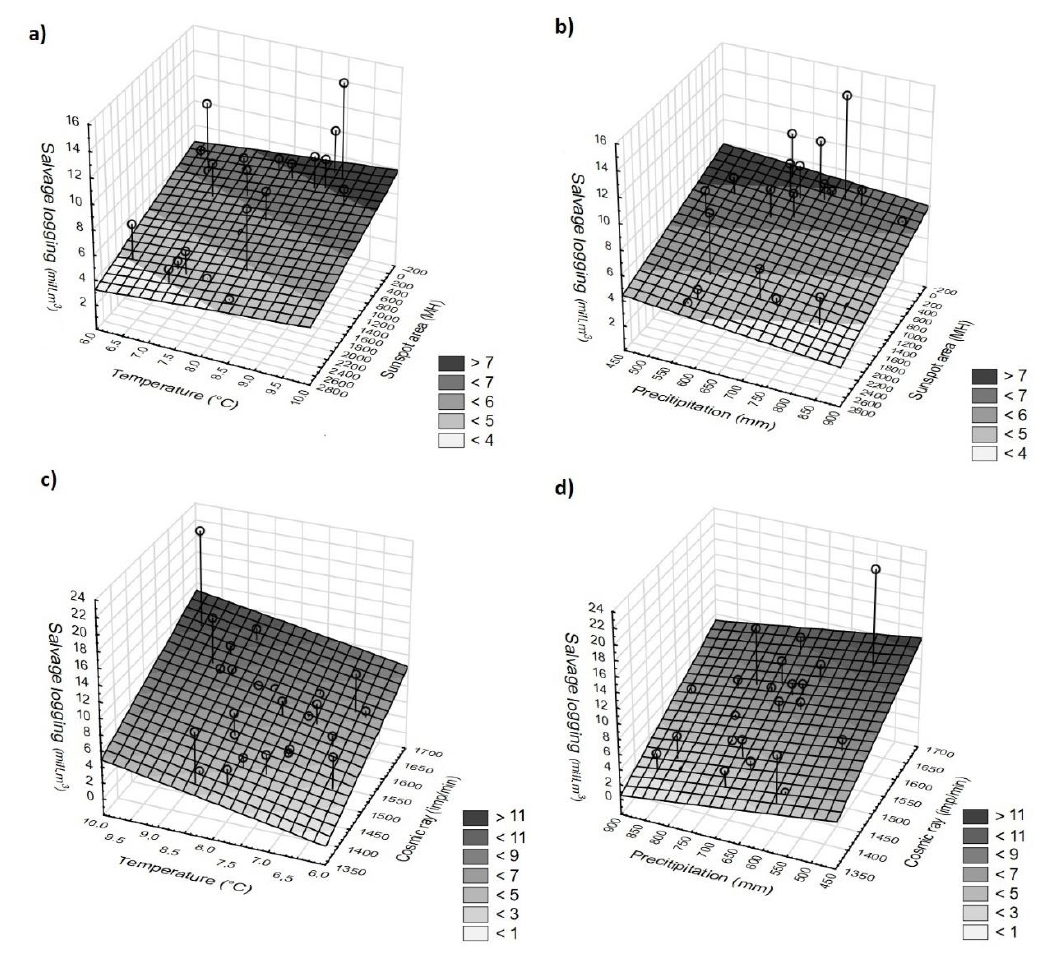
Figure 10. Three-dimensional line chart of salvage logging in relation to the particular factors in the period 1973–2018; ( a ) salvage logging in relation to average annual air temperatures and average annual sunspot area; ( b ) salvage logging in relation to the sum of precipitation and sunspot area; ( c ) salvage logging in relation to average annual air temperatures and average cosmic ray intensity; ( d ) salvage logging in relation to the sum of precipitation and average cosmic ray intensity; explanatory notes: mill. m 3 —million cubic meters of harvested timber; imp / min—impulses / minute; MH—millionths of a hemisphere.